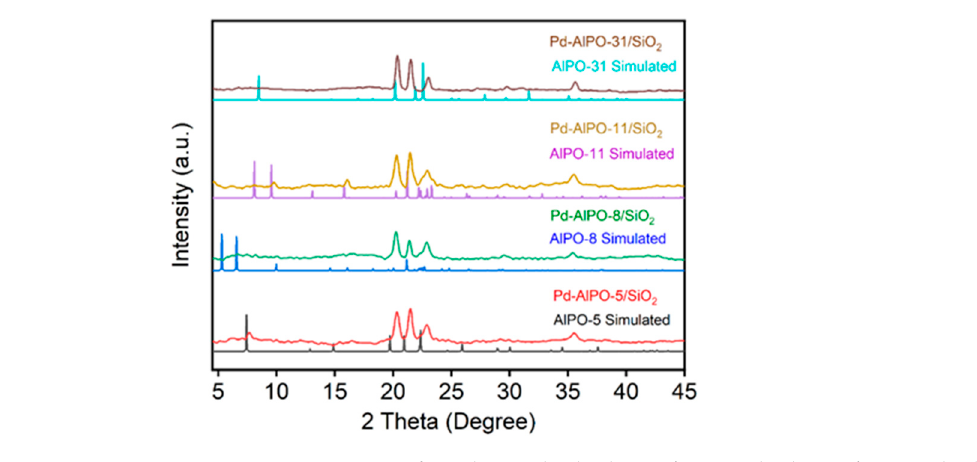
Figure 2. XRD patterns of synthesized Pd-AlPO-5/SiO 2 , Pd-AlPO-8/SiO 2 , Pd-AlPO-11/SiO 2 and Pd-AlPO-31/SiO 2 .